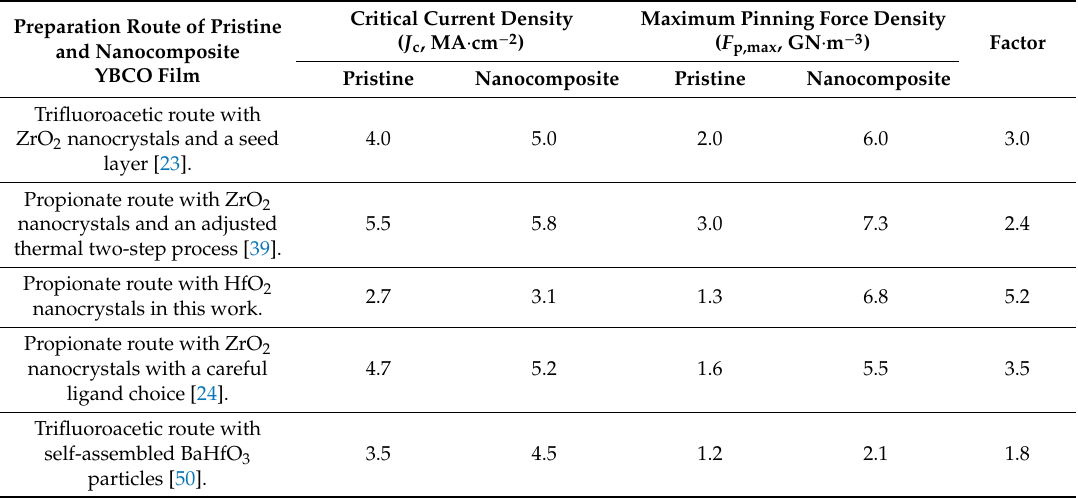
Table 3. Critical current density ( J c ) and maximum pinning force density ( F p,max ) at 77 K of